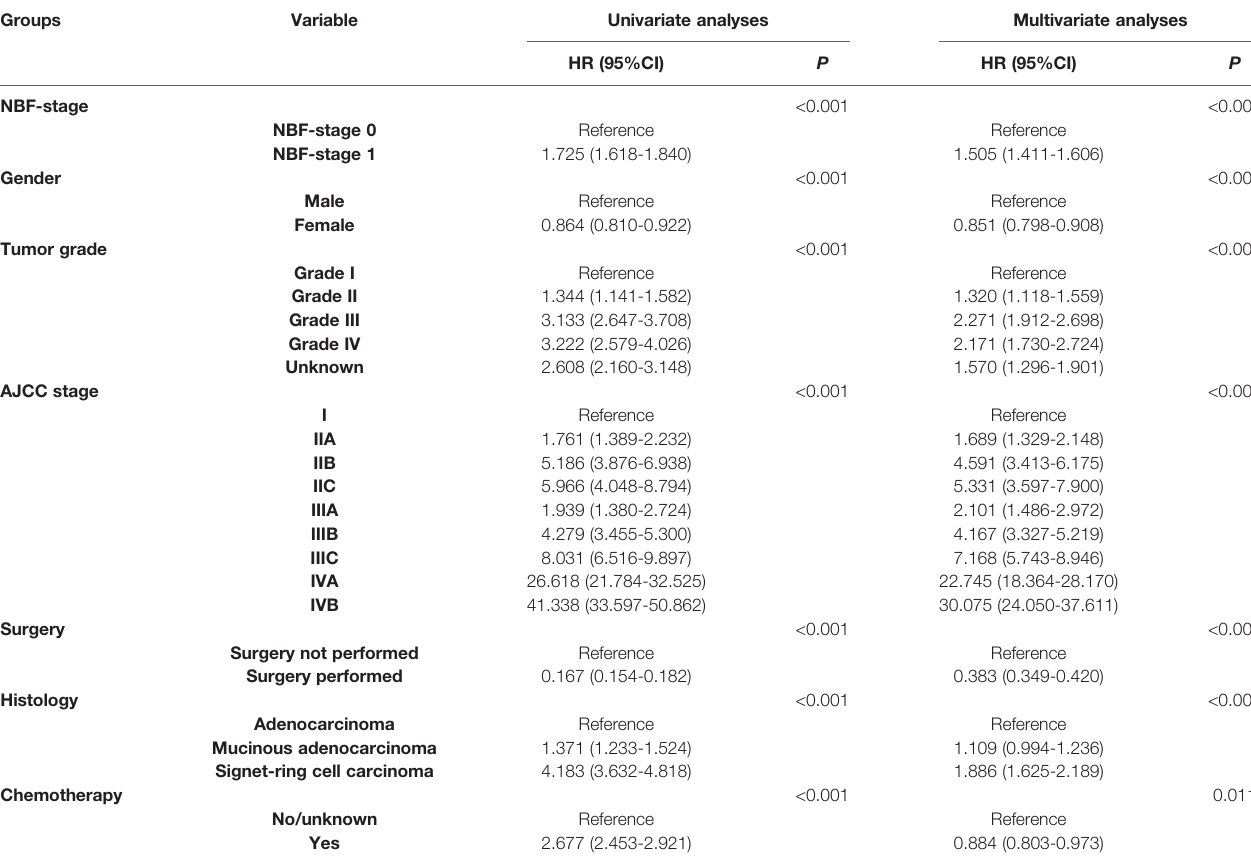
TABLE 3 | Univariate and multivariable Cox regression analyses of NBF stage and other prognostic factors.